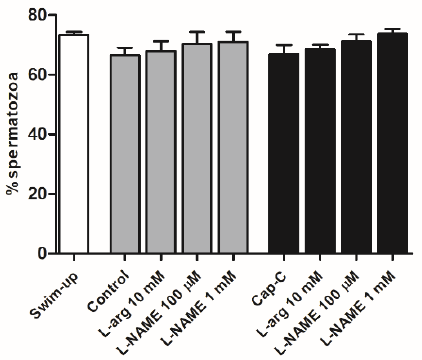
Figure A1. Percentage of viable spermatozoa before (swim-up, white bars) and after in vitro capacitation without (control, grey bars) and with cAMP-elevating agents (Cap-C, black bars) and with L-arginine (L-arg, 10 mM) or L-NAME (100 µM or 1 mM) (n = 7).